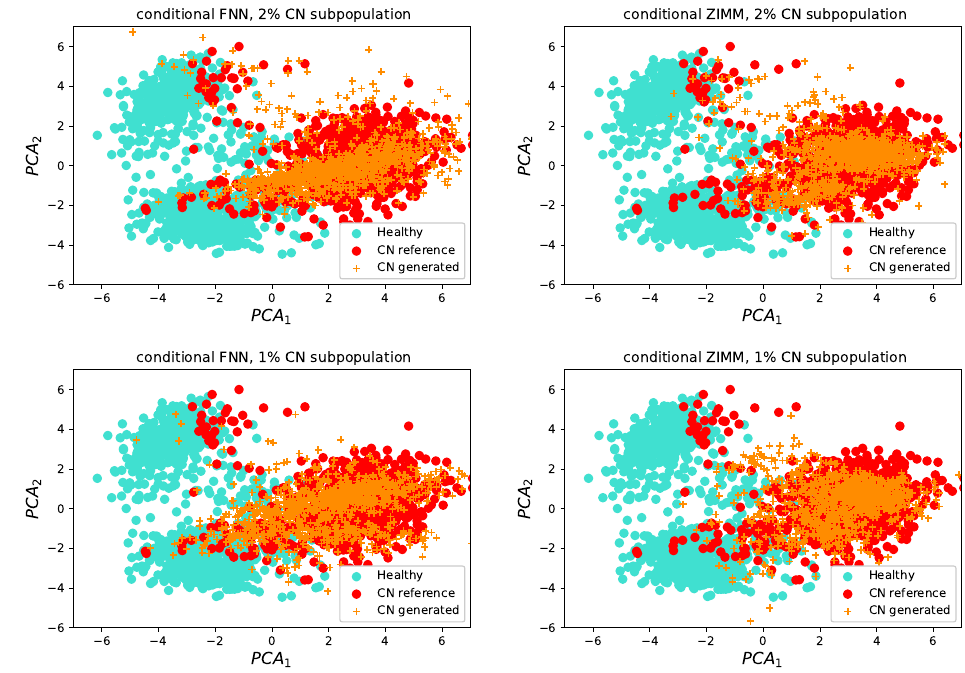
Figure 5. Two dimensional PCA plots on the real 16-dimensional data set. Healthy (turquoise) and diseased (red) cell distributions, each consisting of N = 26,000 samples, are shown in each subplot as reference. Cross symbols indicate the generated cell distribution (orange). ( top ) Performance of cFNN (left) and cZIMM (right) when the training set comprises of 2% ( N = 520) diseased samples. ( bottom ) Performance of cFNN (left) and cZIMM (right) when the training set comprises of 1% ( N = 260) diseased samples. Detailed histograms are included in Supplementary Figure